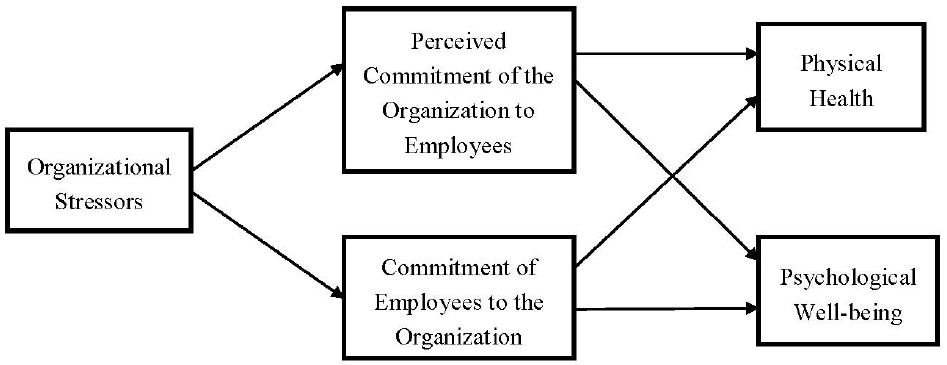
Figure 1. Conceptual scheme of this